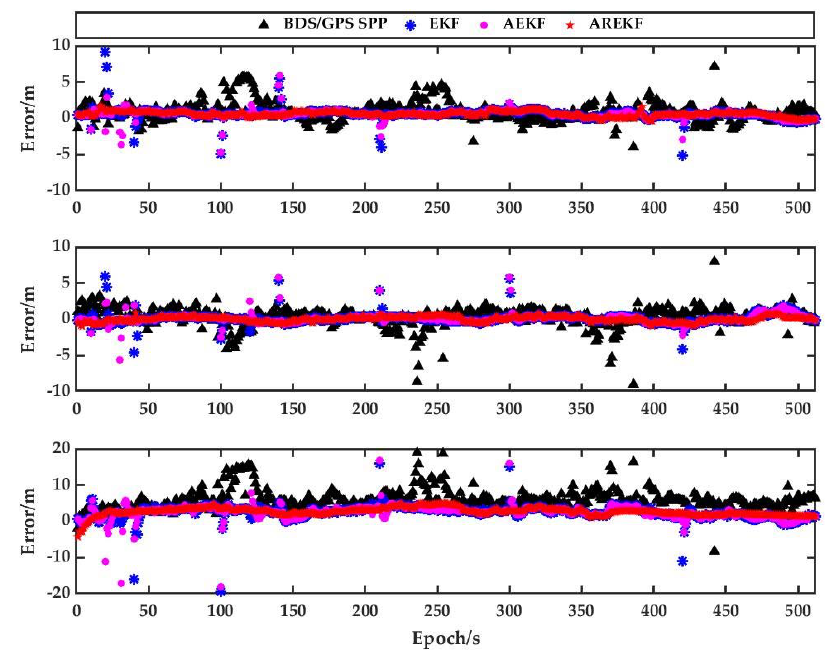
Figure 9. Positioning residuals of each scheme.